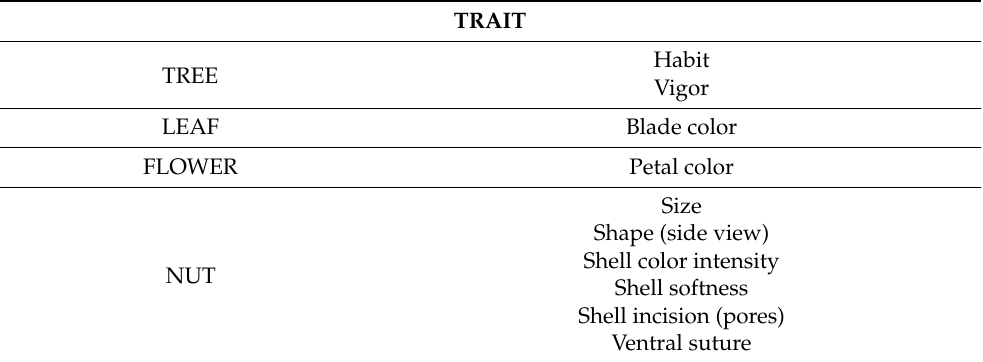
Table 6. List of phenotypic traits selected for this